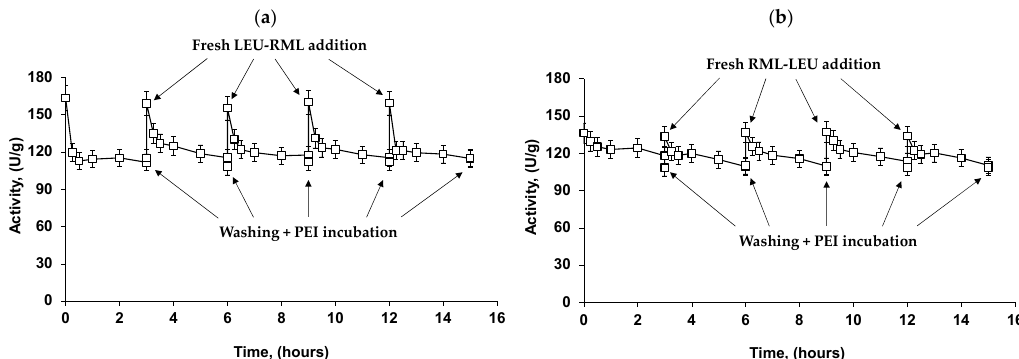
Figure 10. Cycles of inactivation, incubation and washing with ammonium sulfate, incubation with PEI and reloading of the least stable lipases of the combilipases. The steps are indicated by the arrows. ( a ) Octyl-VS-CALA-TLL-CALB-PEI-LEU-RML and ( b ) octyl-VS-CALB-TLL-CALA-PEI-RML-LEU. Inactivations have been performed by incubation at pH 7.0 and 60 °C. Other specifications are described in Methods.